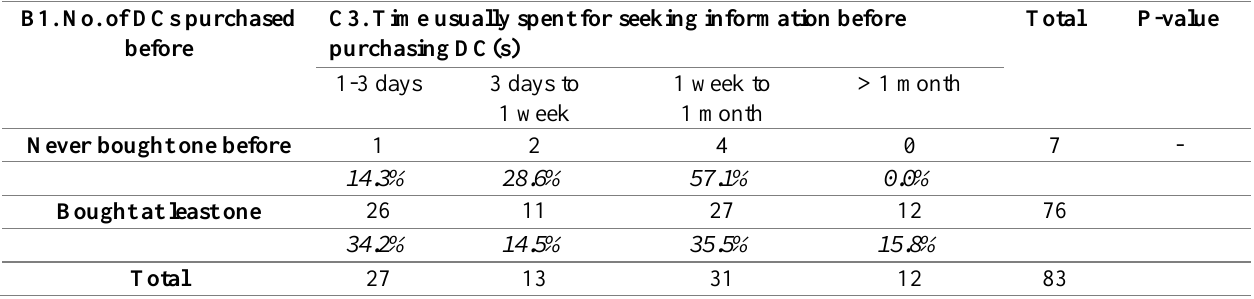
Table 3. Result For Hypothesis 2